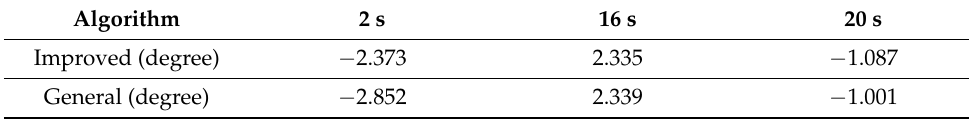
Table 3. Maximum centroid side slip angle